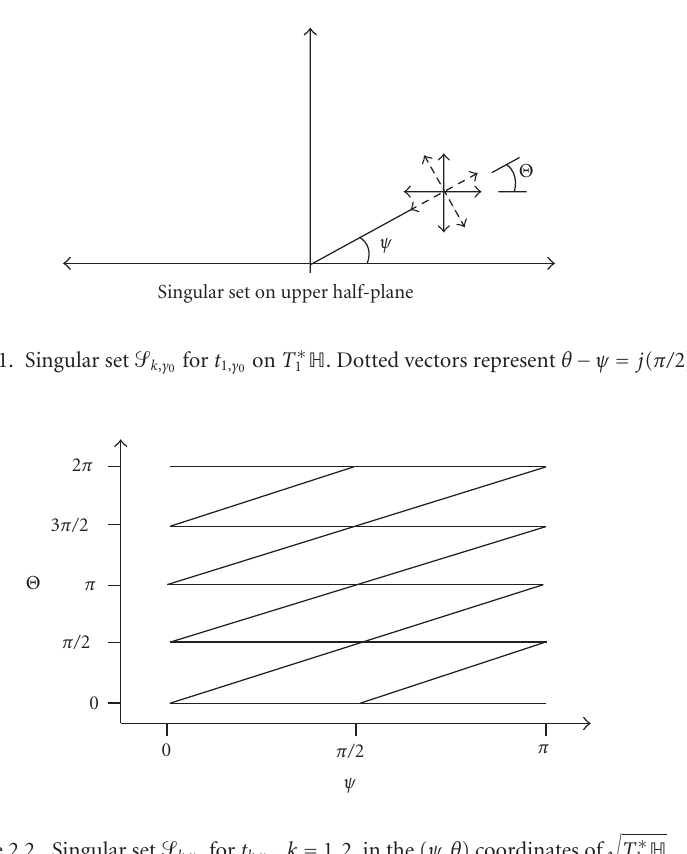
Figure 2.2. Singular set (cid:1) k , γ